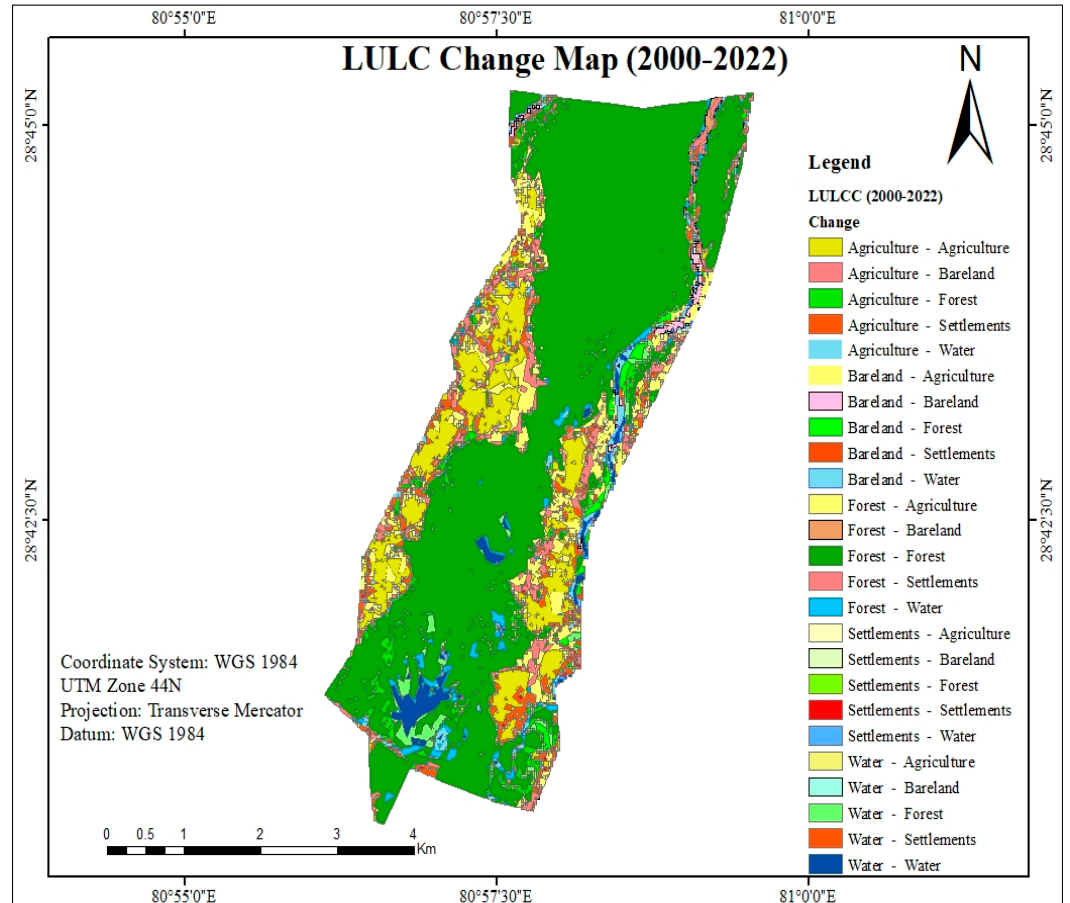
Figure 6. Change detection of land use and land cover (LULC) change in Ghodaghodi Lake Complex, Nepal, between 2000 (April) and 2022 (April).